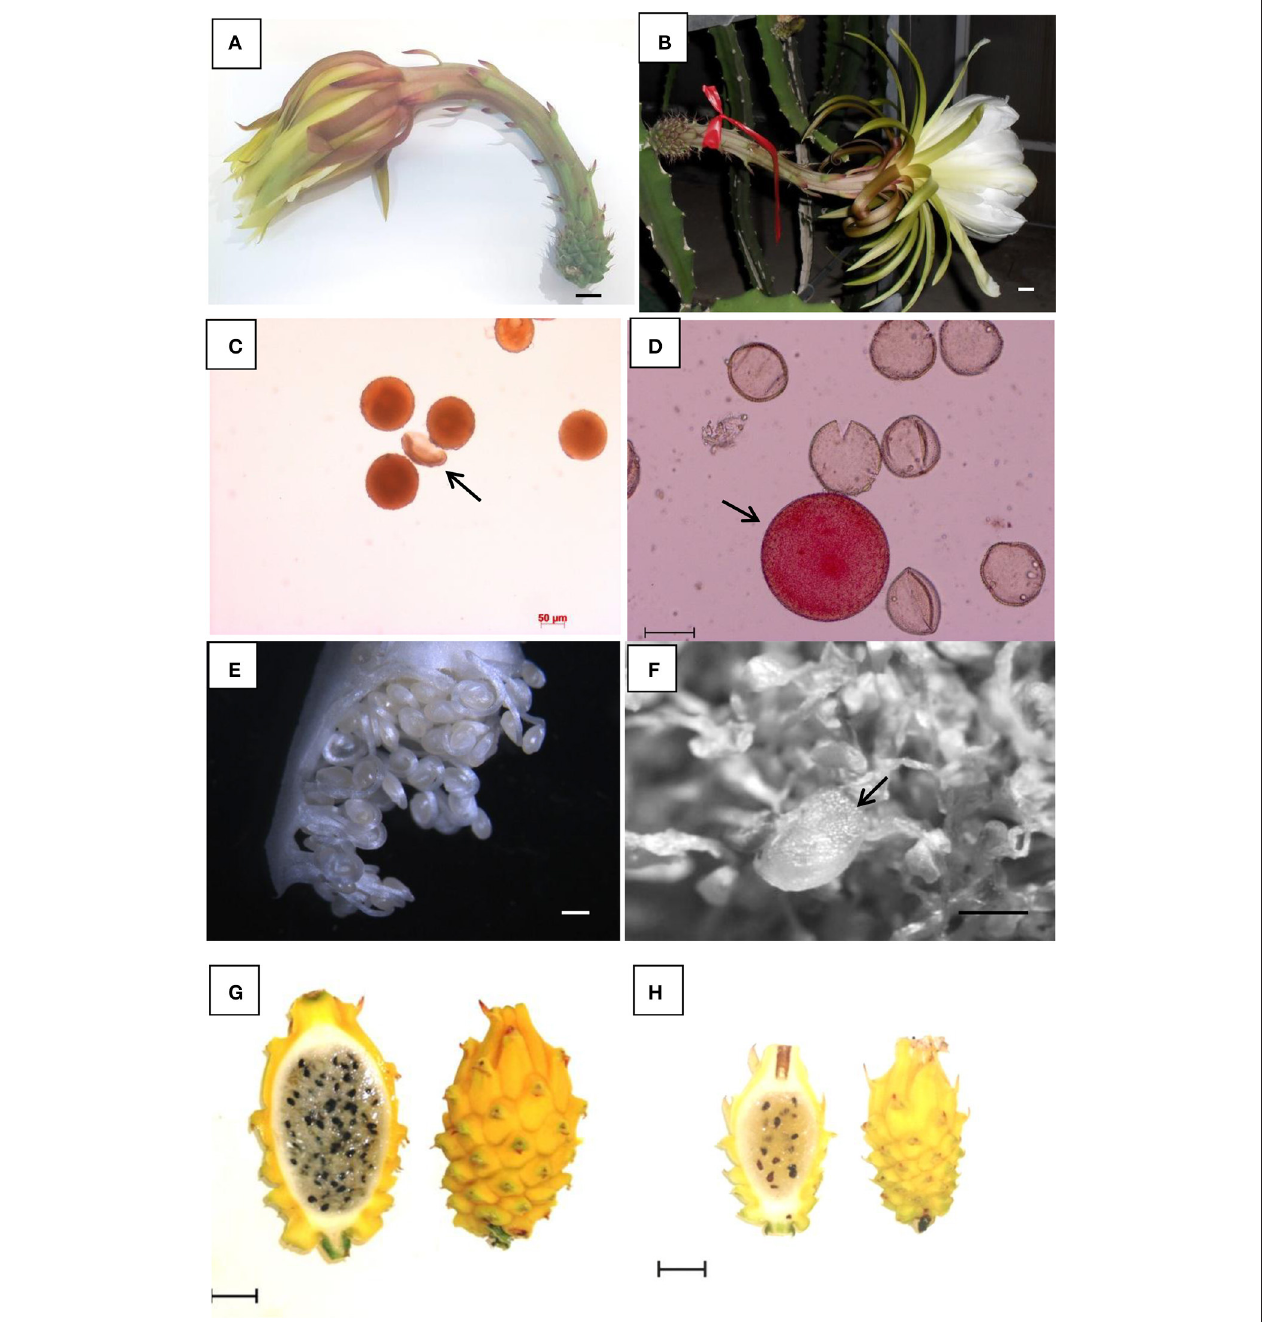
FIGURE 3 | H. megalanthus (A,C,E,G) and gamete-derived H. megalanthus lines (B,D,F,H) . (A,B) Flower at anthesis in the donor plant and in the di-haploid line 74 (scale bar 1cm). (C,D) Well-stained pollen grains with a normal subglobular shape and a single aborted grain (arrow) in the donor plant, and aborted (shrunken and unstained) pollen grains from the di-haploid line 1060 showing a single well stained grain (arrow) (scale bar 50 µ m). (E,F) Ovules at anthesis in the donor plant (normal shaped) and in the double di-haploid line 1347 showing a single normal developed ovule (arrow) and several aborted ovules (scale bar 0.5mm). (G,H) Mature fruit in the donor plant and in the di-haploid line 8, showing aborted (brown) and viable (black) seeds (scale bar 2cm).